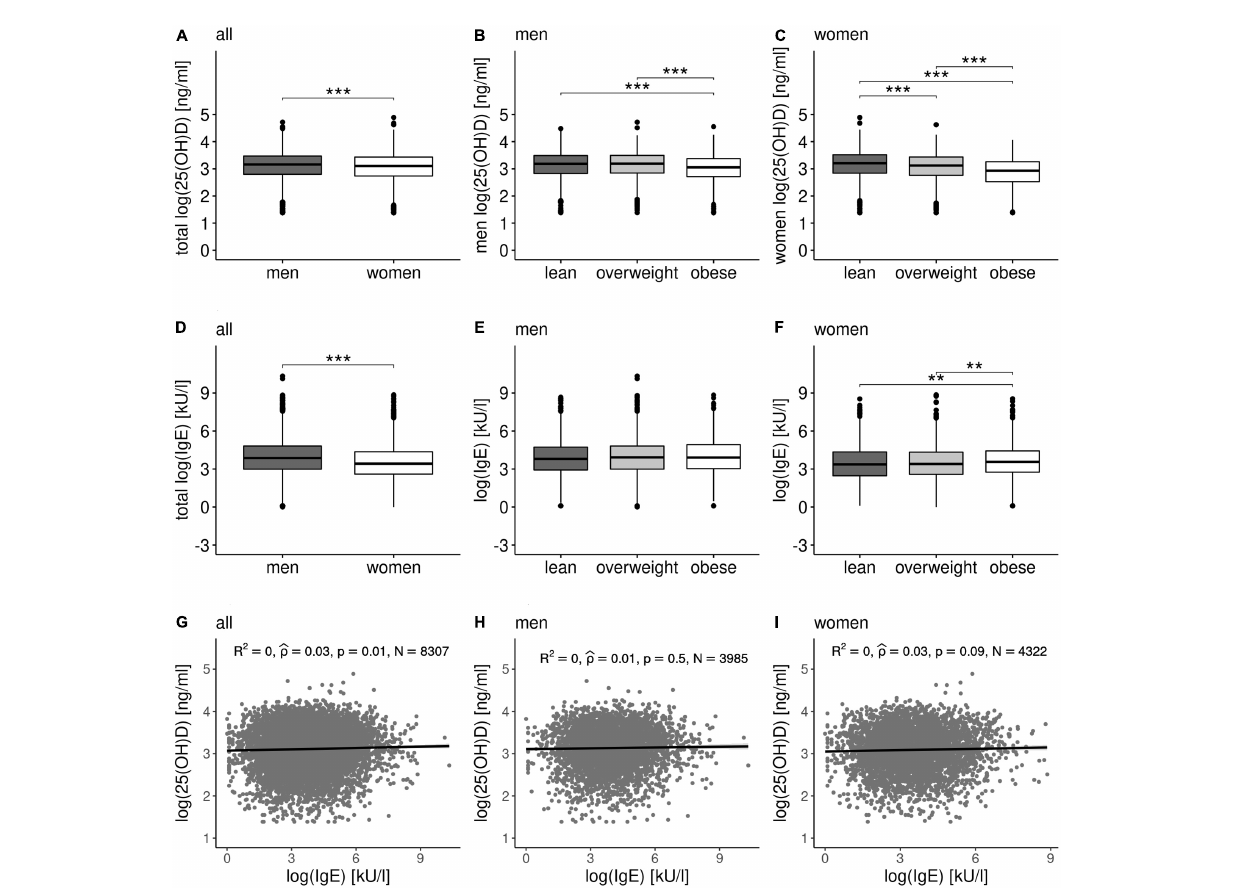
FIGURE1 IgE and 25(OH)D concentrations and correlation studies. 25(OH)D concentrations of the entire study population of the LIFE-Adult cohort grouped by (A) gender ( p < 0.001), BMI categories of (B) men ( p < 0.001), and (C) woman ( p < 0.001). IgE concentrations grouped by (D) gender ( p < 0.001), BMI categories of (E) men ( p = 0.16), and (F) woman ( p = 0.003). Statistical significance was evaluated by Kruskal–Wallis and Dunn’s post hoc test with Bonferroni–Holm correction for multiple testing (indicated as ** <0.01 and *** <0.001). The 25(OH)D and IgE concentrations are significantly gender-specific. Significant differences were also observed in lean and overweight subjects compared to obese subjects when considering 25(OH)D concentrations in men and IgE concentrations in women. However, all BMI categories show significant differences in 25(OH)D concentration in women. No correlation is revealed between 25(OH)D and IgE concentrations in (G) the entire cohort (rho Spearman = 0.03, R 2 = 0, p -value 0.01), in (H) men (rho Spearman = 0.01, R 2 = 0, p -value 0.5), and in (I) women (rho Spearman = 0.03, R 2 = 0, p -value 0.09),